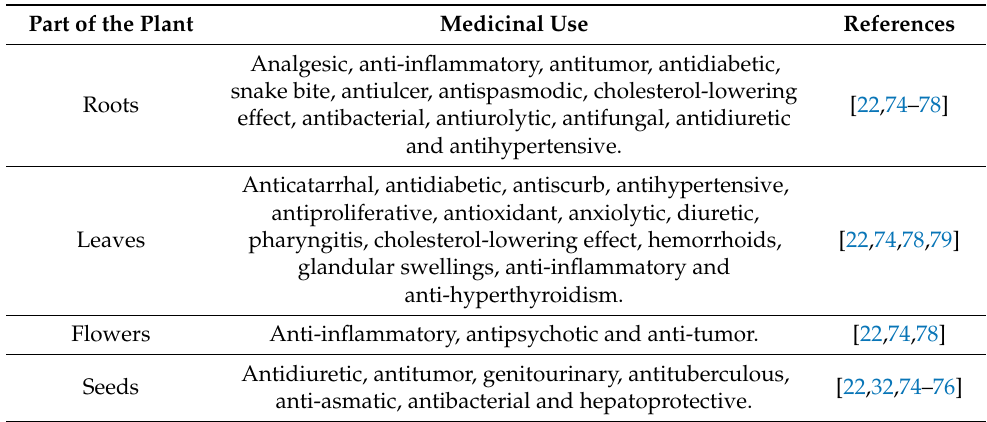
Table 6. Main medicinal properties according to the part of M. oleifera